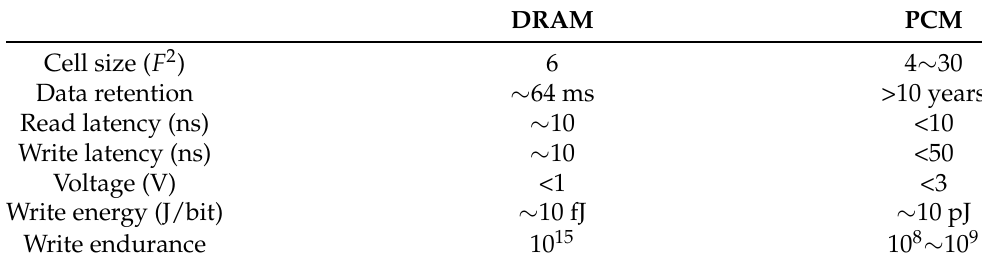
Table 1. Comparison of DRAM and